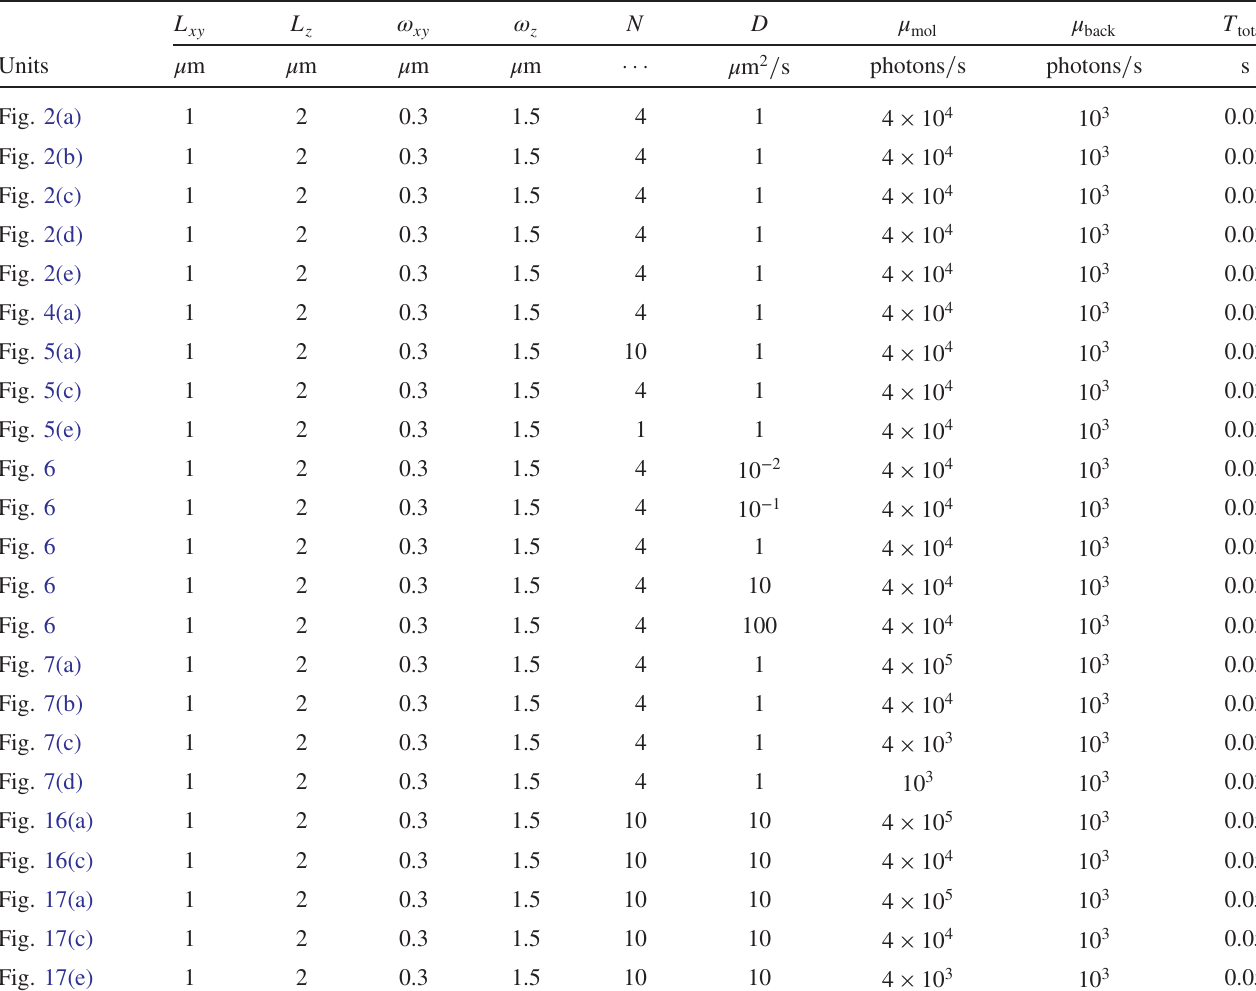
TABLE IV. Parameter values used in the generation of the synthetic traces. Choices are listed according to